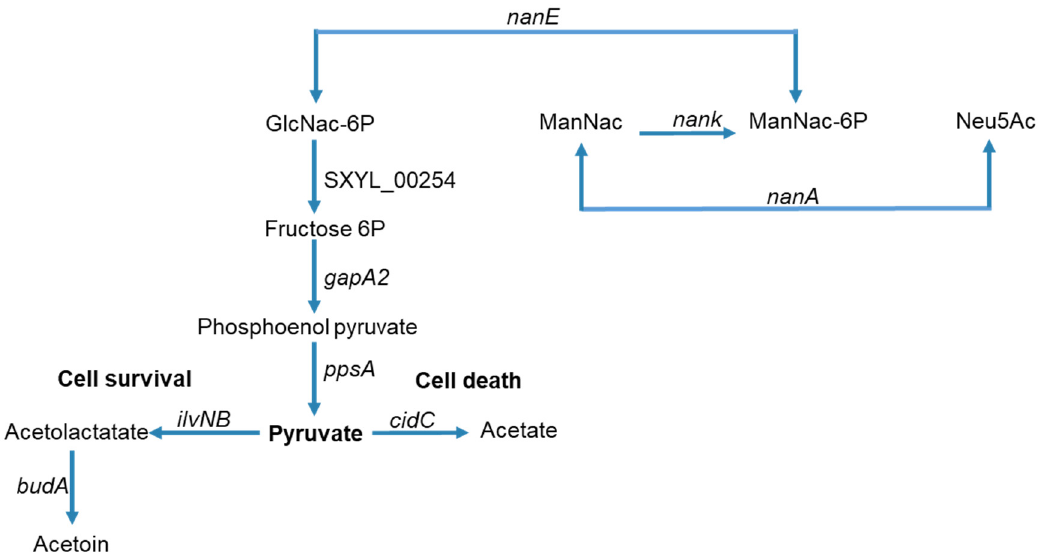
Figure 4. Summary of carbohydrate and amino sugar catabolism in S. xylosus biofilm showing the up-regulated genes (the level of expression of these genes and the corresponding enzymes are given in Table 1). GlcNac-6P = N -acyl- D -glucosamine 6-phosphate, ManNac = N -acyl- D -mannosamine, ManNac-6P = N -acyl- D -mannosamine 6-phosphate, Neu5Ac = N -acetyl neuraminate.